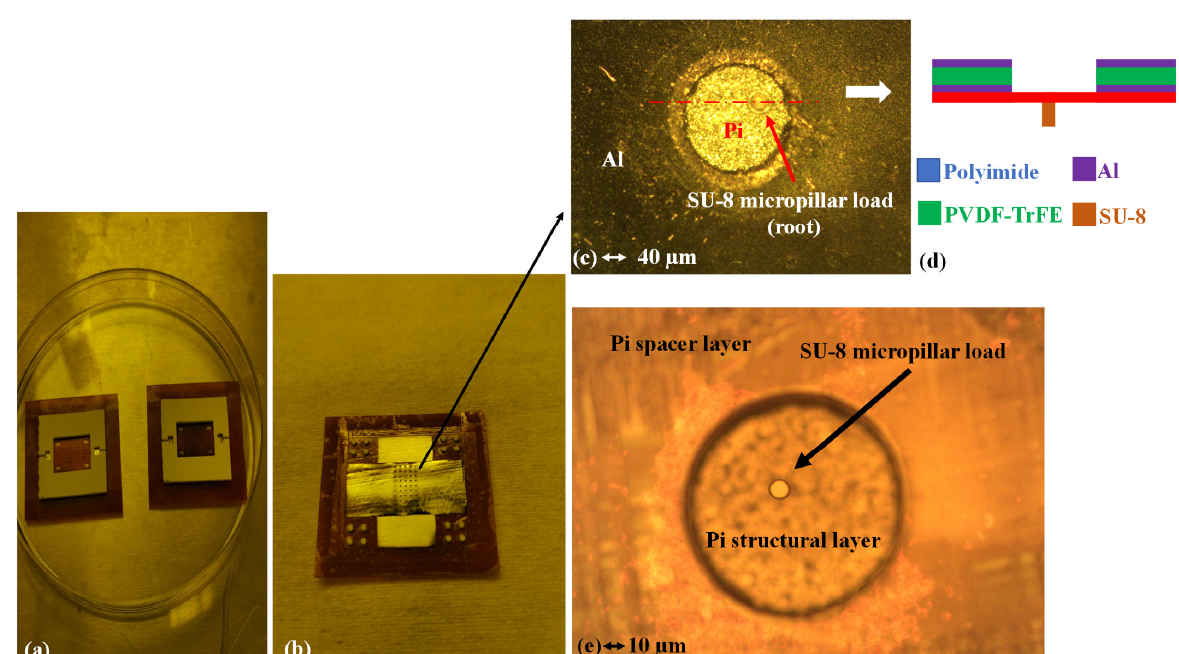
Figure 11. Optical images of the piezoelectric mass sensor arrays. ( a ): the two MEMS sensor arrays after the complete microfabrication flow, backside. ( b ): The front side for one of the devices before being fixed to the support frame. ( c ) Darkfield microscopic image of a single mass sensor with SU-8 micropillar load, front side. ( d ) Illustration of cross-section view along the red dashed line. ( e ) Yellow microscopic image of a single mass sensor with SU-8 micropillar load, backside.